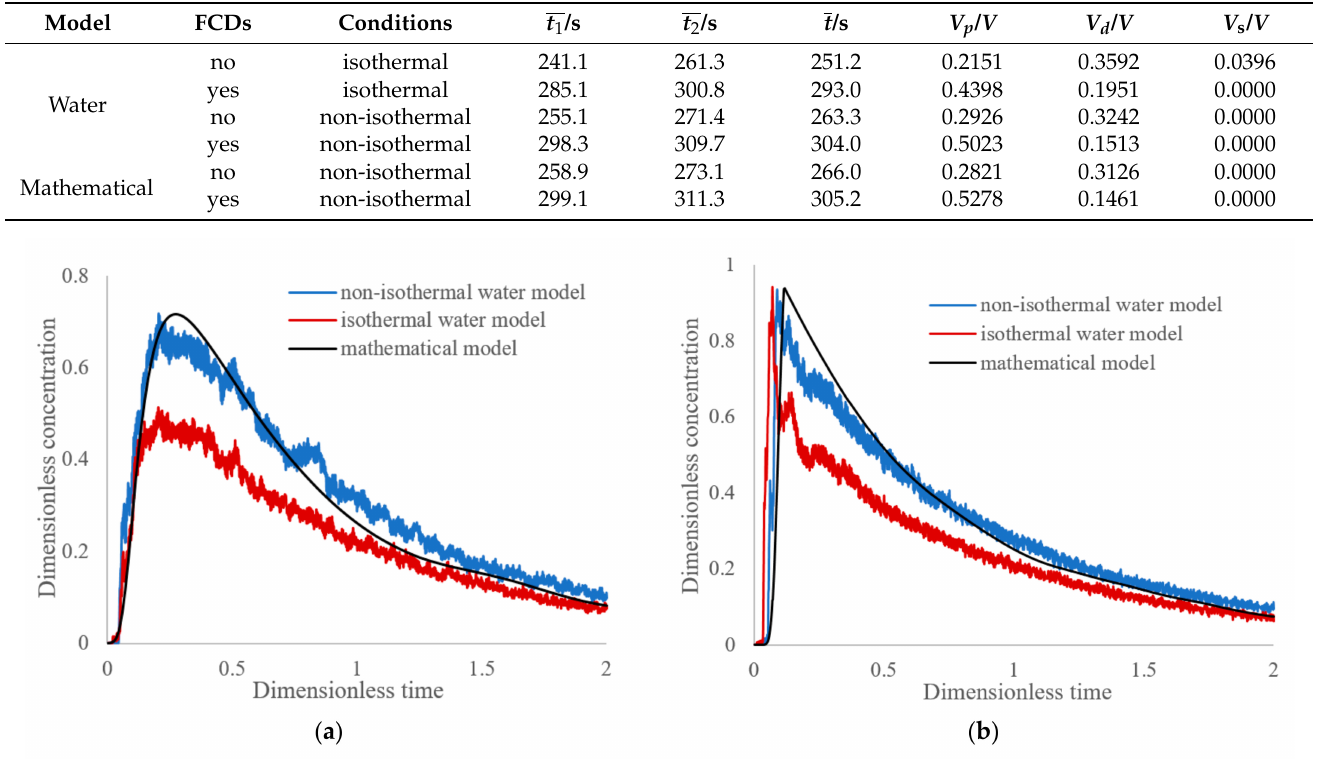
Figure 4. The RTD curves with FCDs. ( a ) 1st strand; ( b ) 2nd